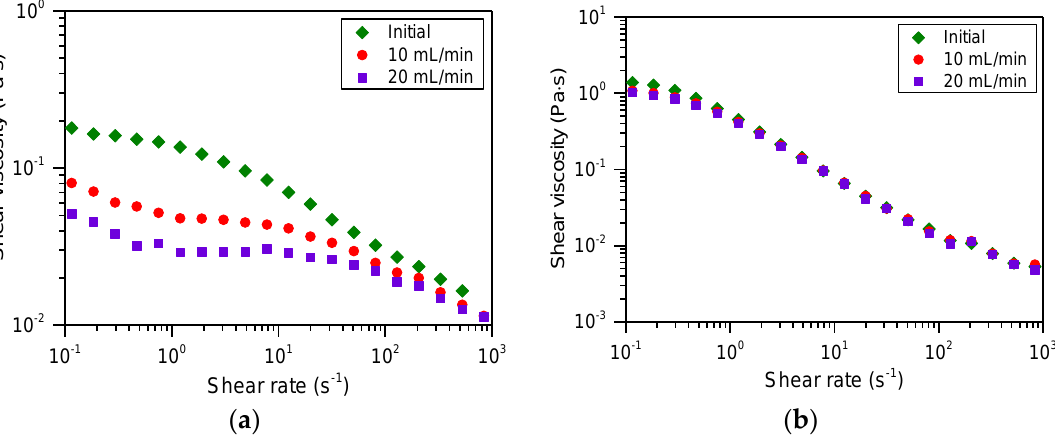
Figure 11. Shear viscosity of ( a ) HPAM and ( b ) the biopolymer after passing through the capillary (2 wt% NaCl).